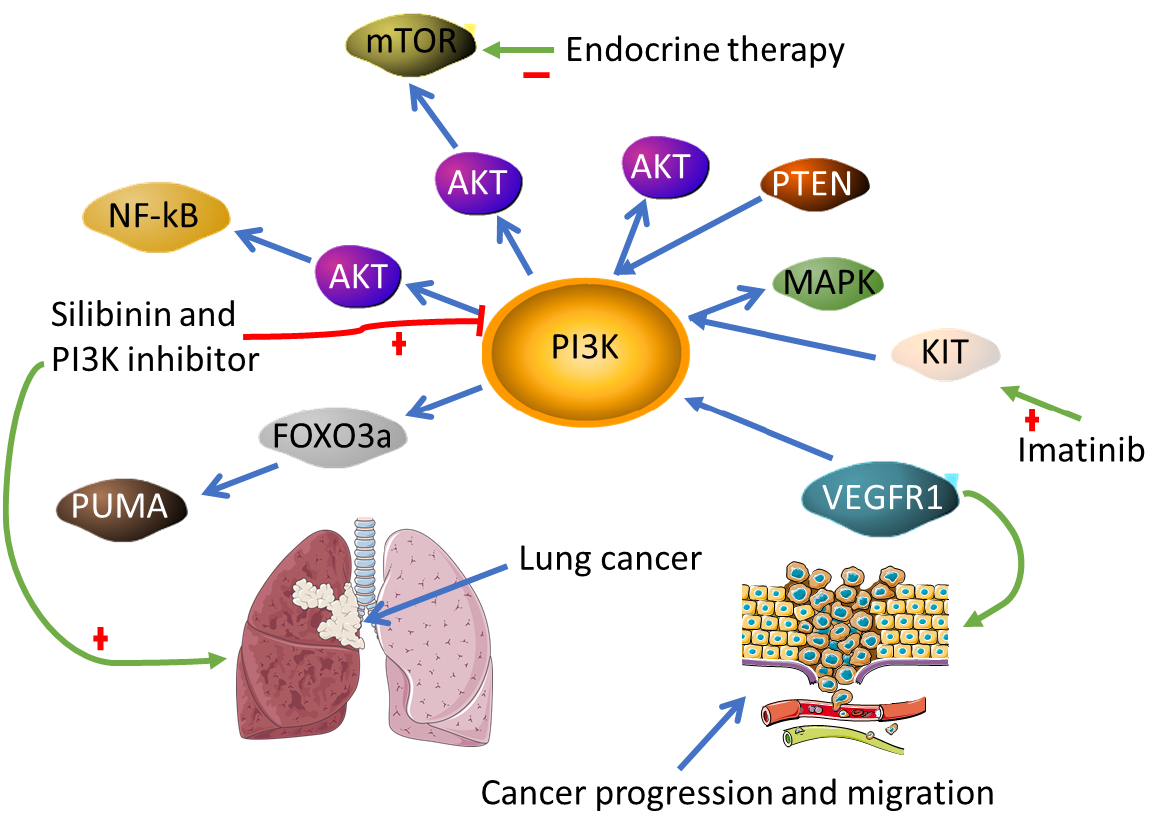
Figure 7. Factors involved in PI3K inhibitor therapeutic response in cancer.